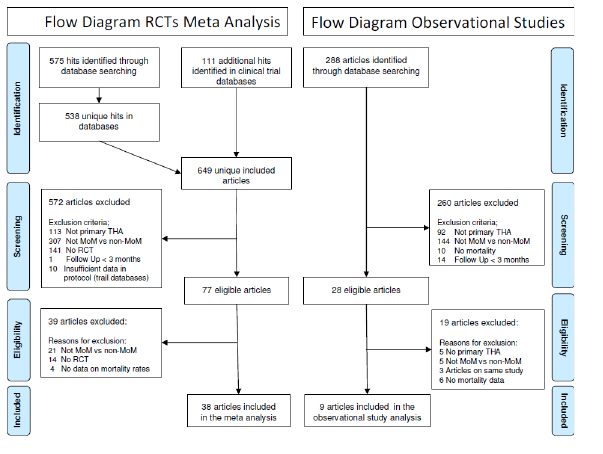
Fig 1. PRISMA flow